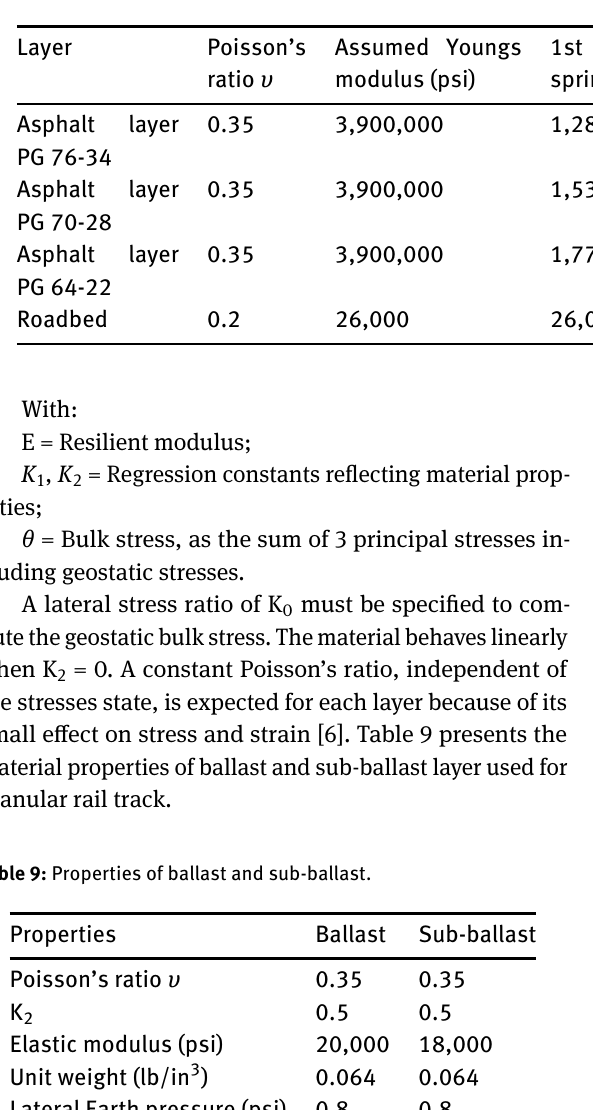
Table 8: Poisson’s ratio, assumed Youngs modulus, and Youngs modulus through seasons.